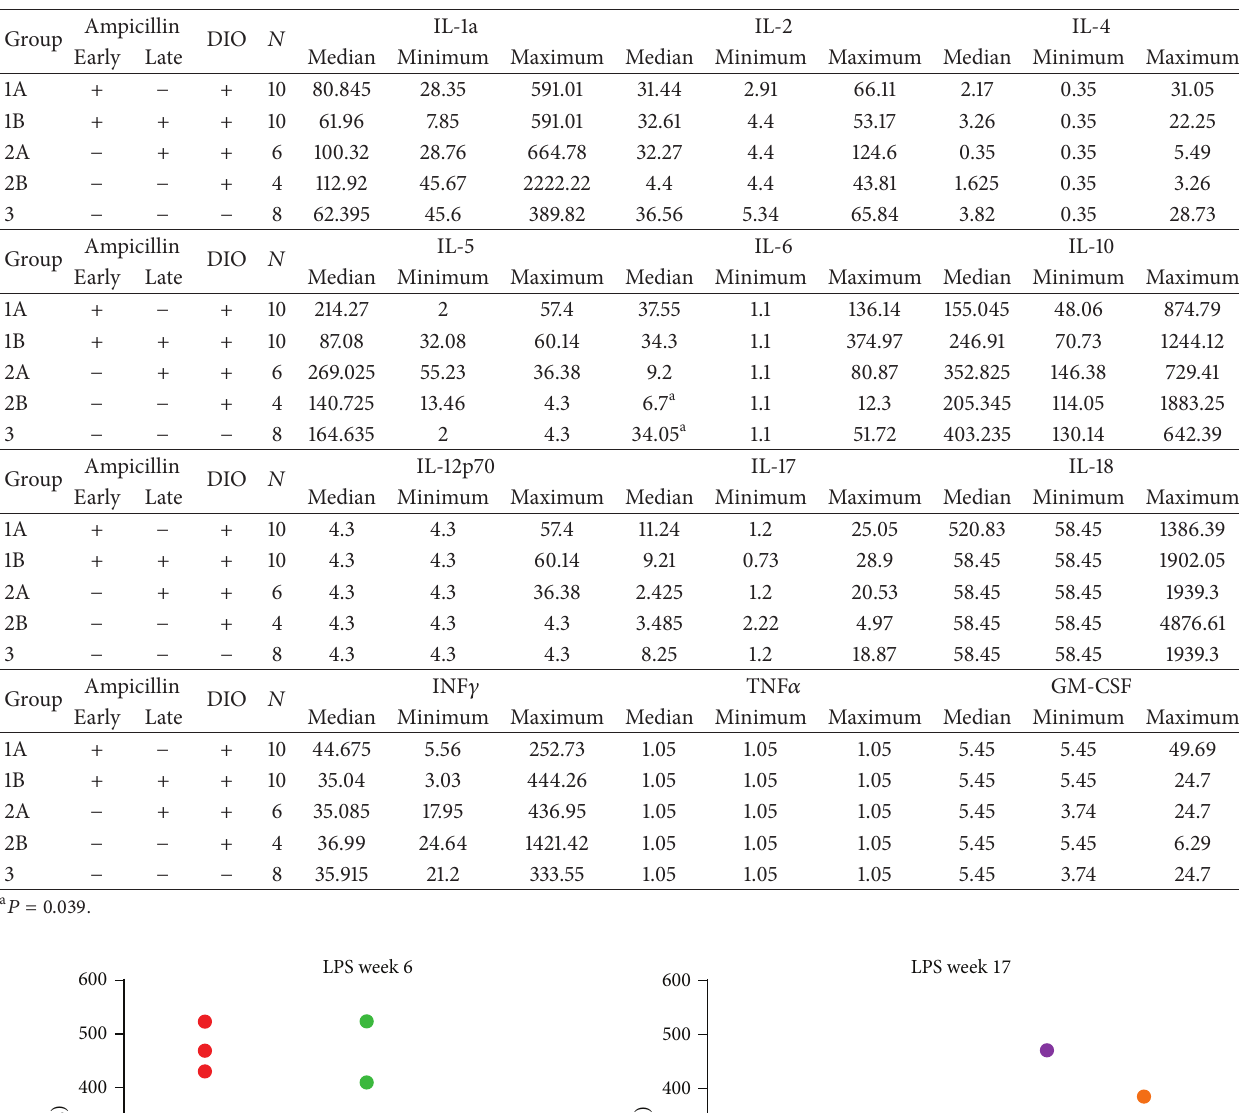
Table 1: Serum cytokines in diet-induced obese C57BL/6 mice treated or not treated with Ampicillin from birth to five weeks of age, from 12 to 16 weeks of age, or both.